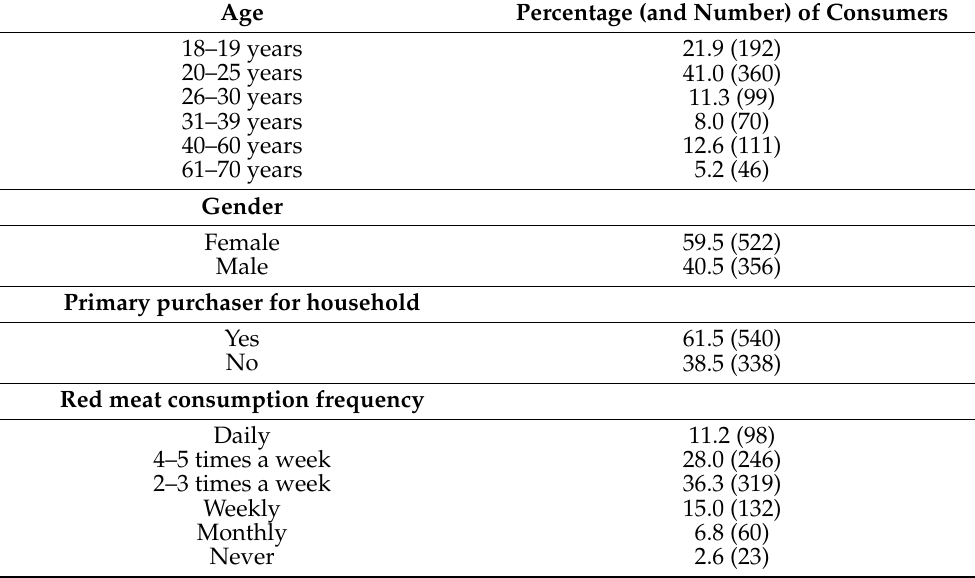
Table 3. Percentage (and number) of consumers within each demographic and meat consumption